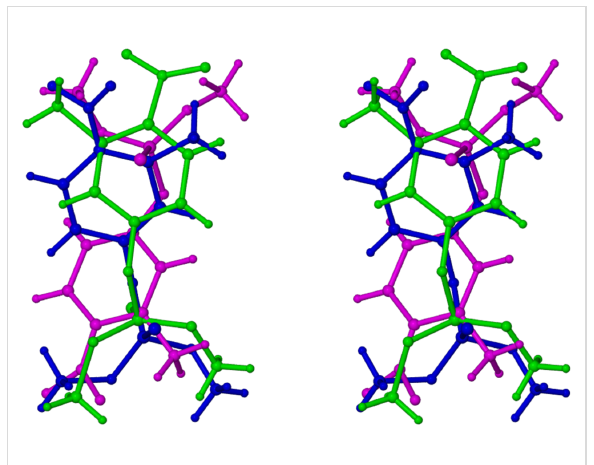
Figure 6: Stereoview of the three disordered guest components that occupy the cavity of host molecule B. Guest components B (green) and C (blue) have similar orientations while component E (pink) adopts the opposite orientation.